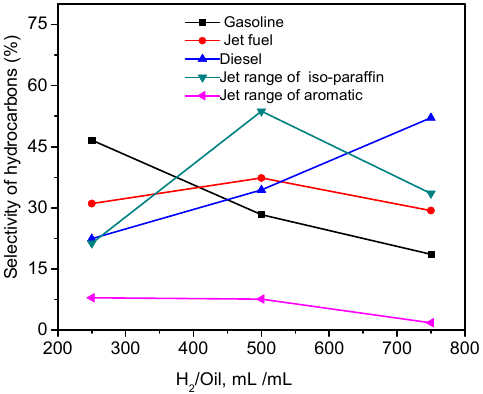
Figure 8. Selectivity for the formation of hydrocarbons using NiMo/SBUY-MCM-41 at different H 2 /Oil ratios. Reaction conditions: 380 °C, 3 MPa.